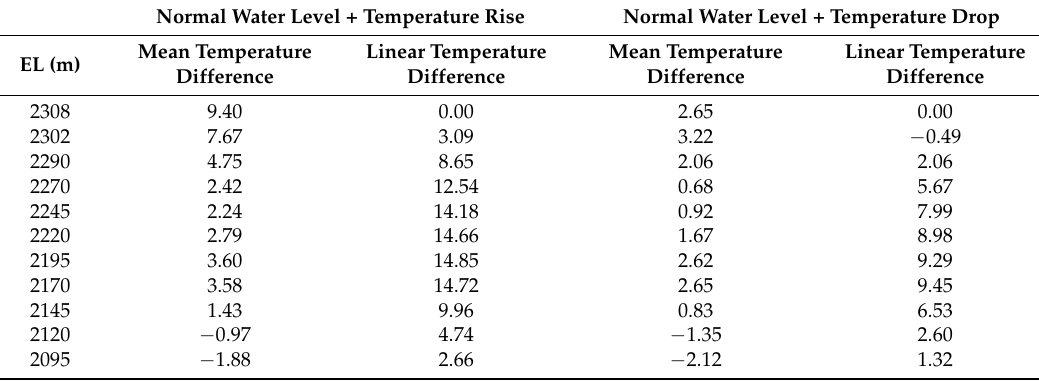
Table 3. The mean and linear temperature difference under normal water level.